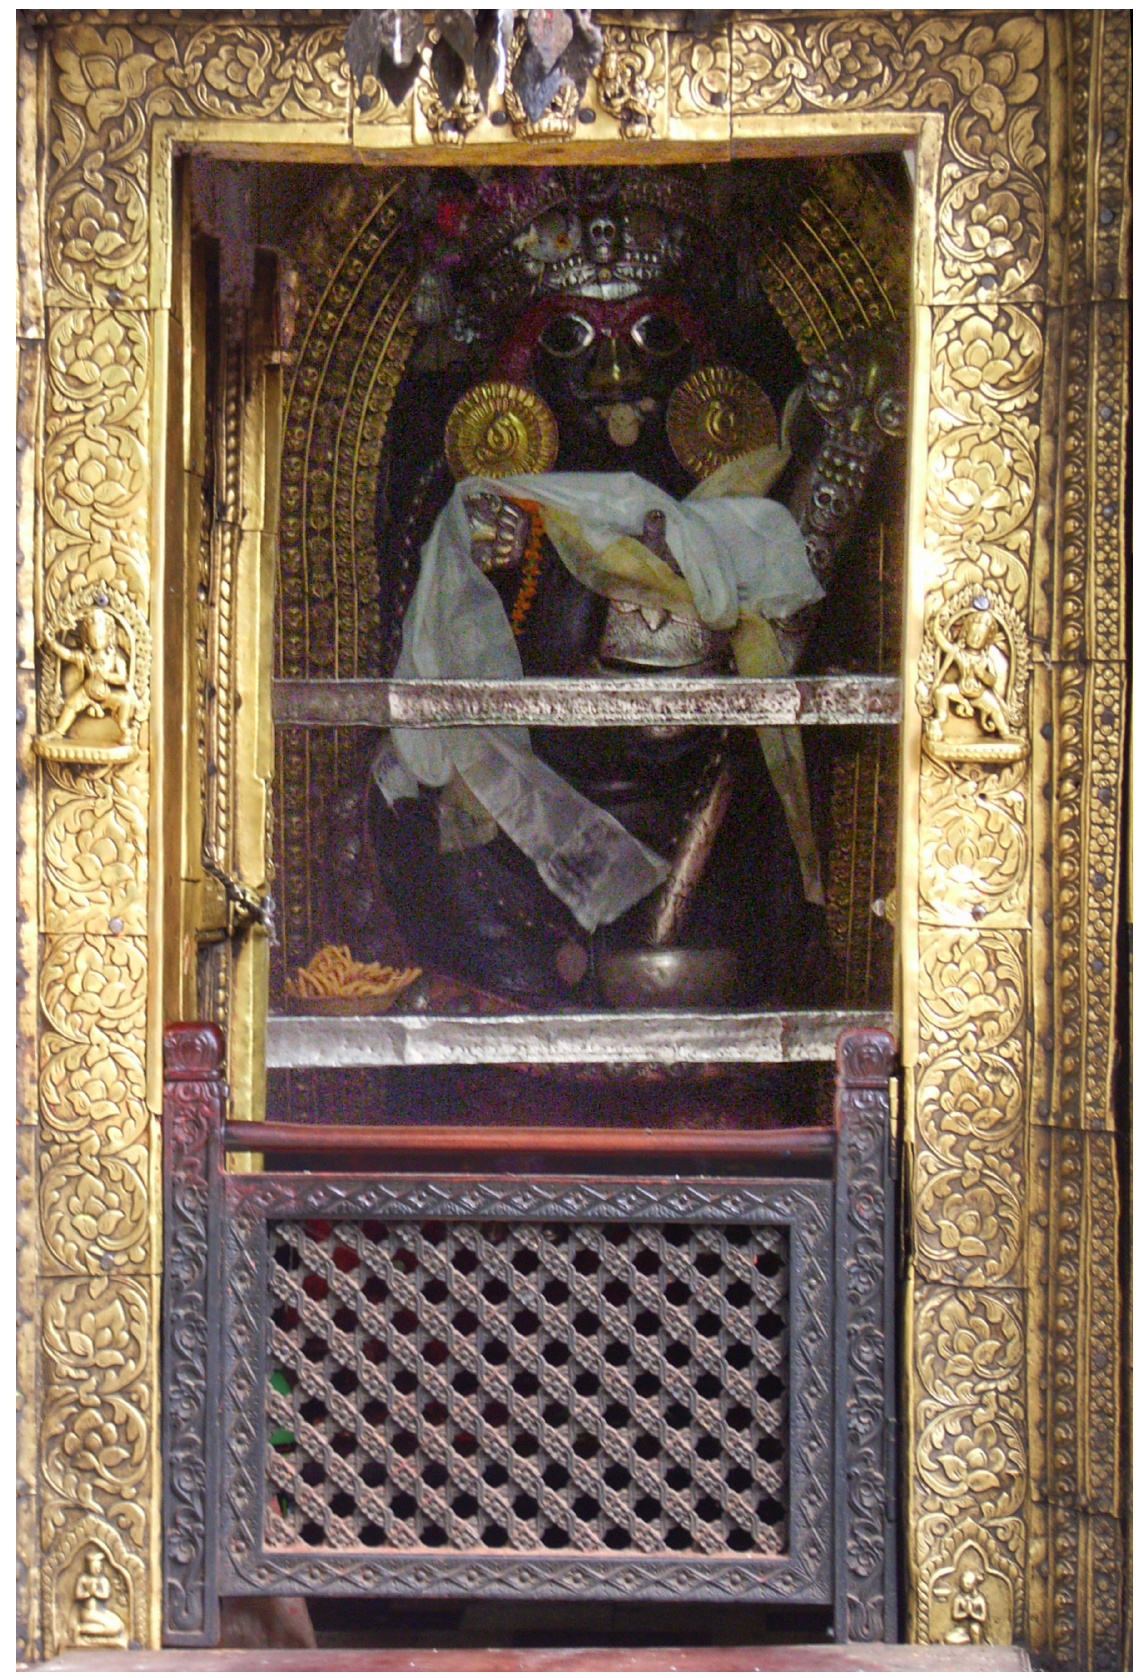
Figure 10 Two-armed Vajramahākāla enshrined at Tundikhel, Kathmandu, Nepal. 10–12th century or later. Source: author,